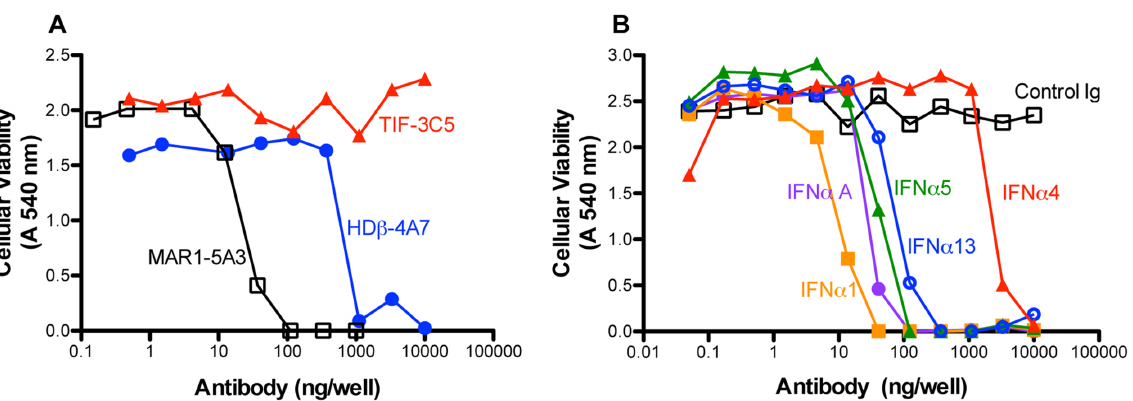
Fig 3. Neutralization of type I IFN induced antiviral activity in vitro . Ten units IFN- β ( A ) or IFN- α ( B ) were preincubated for 1 h with indicated mAbs and then added to L929 cells overnight. Ten units/well type I IFN activity used in these assays are as follows: IFN- β , 16 pg; IFN- α A, 22 pg; IFN- α 1, 15 pg; IFN- α 4, 70 pg; IFN- α 5, 20 pg; IFN- α 13, 13 pg. IFN-treated cells subsequently were infected with VSV for 48 h and cell viability determined by crystal violet staining and optical density measurements. Results shown are representative of three or more independent experiments.